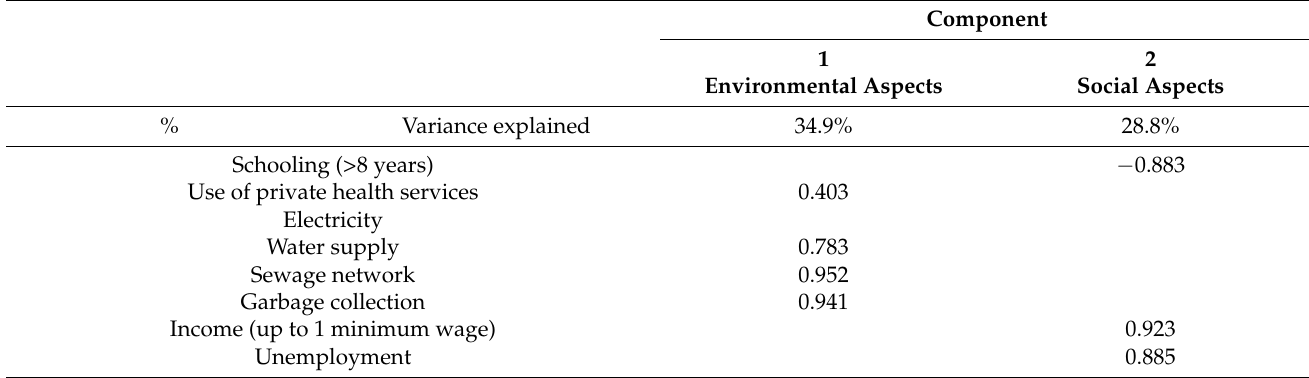
Table 2. Component loadings obtained by principal component analysis and Oblimin rotation * of the secondary sociode- mographic and economic data.